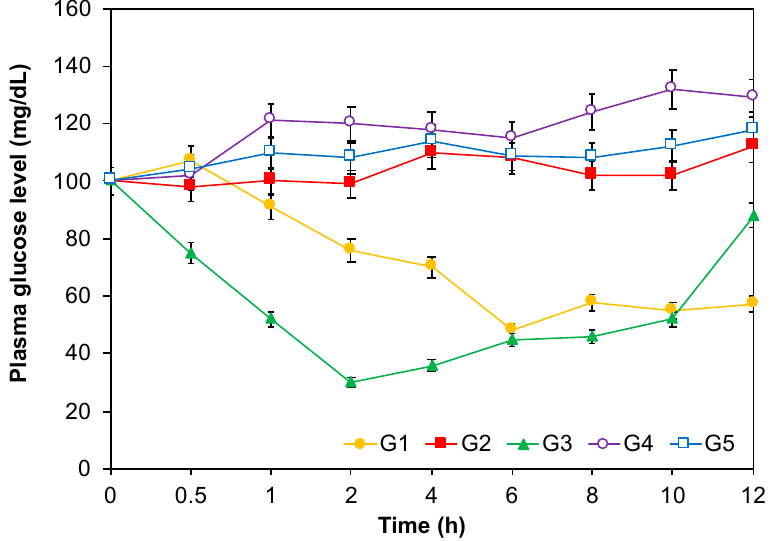
Figure 4. Percentage decrease of the blood glucose level in rats treated with insulin-loaded MP formulations ( n = 5). Groups G1–G5: G1 = received insulin-loaded MPs (formulation A5), G2 = received pure insulin solution, G3 = received subcutaneous insulin, G4 = received water, G5 = received